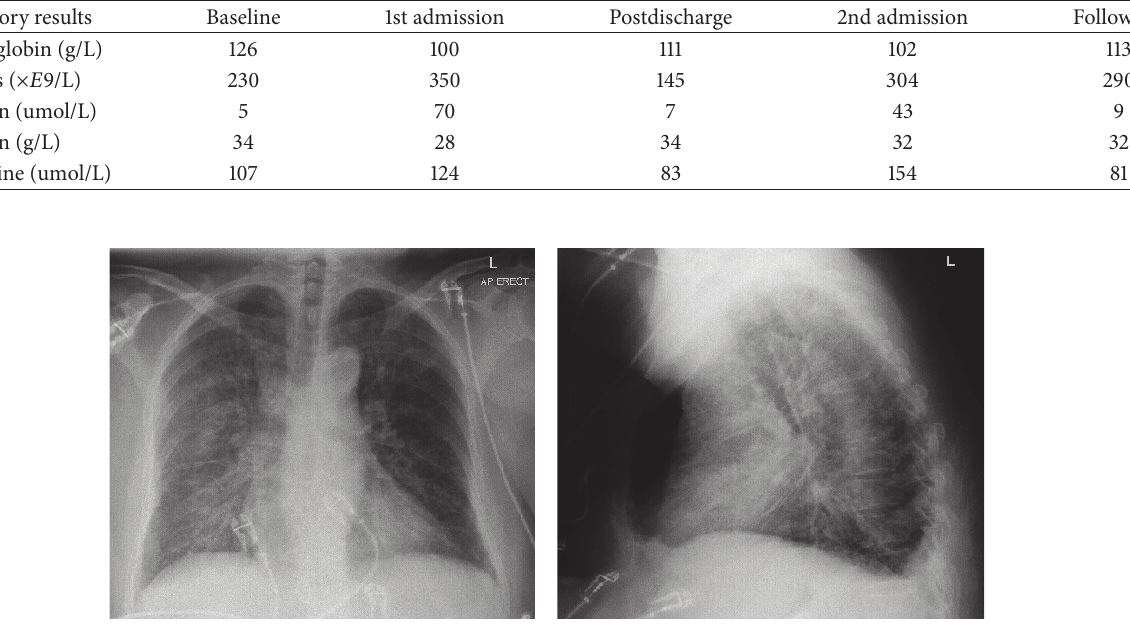
Figure 1: CXR on first admission.